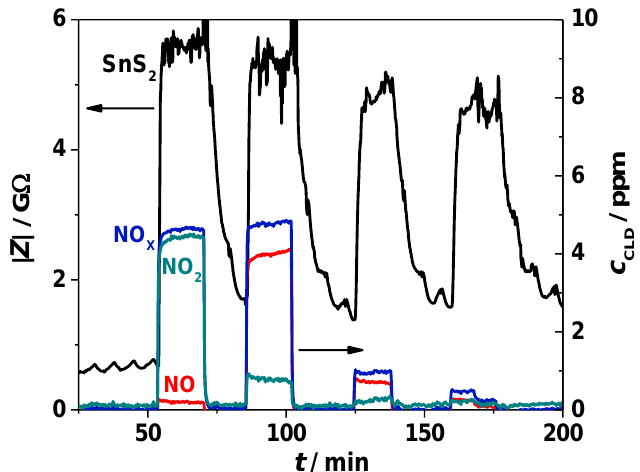
Figure 4. Complex impedance | Z | of the SnS 2 sensor determined at f = 1 Hz at 130 °C during NO x exposure and the added NO x concentration analyzed by CLD downstream the sensor